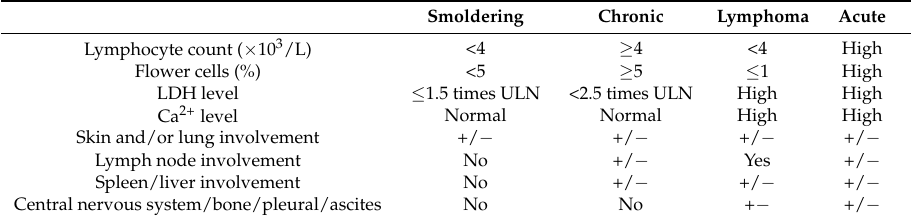
Table 2. Shimoyama classification defining four adult T-cell leukemia/lymphoma